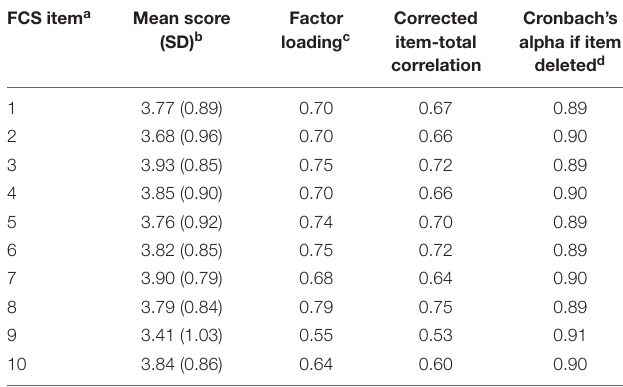
TABLE 2 | Descriptive statistics, factor loadings, and internal consistency of the Chinese version of the Family Communication Scale in the population-based sample ( N = 687).